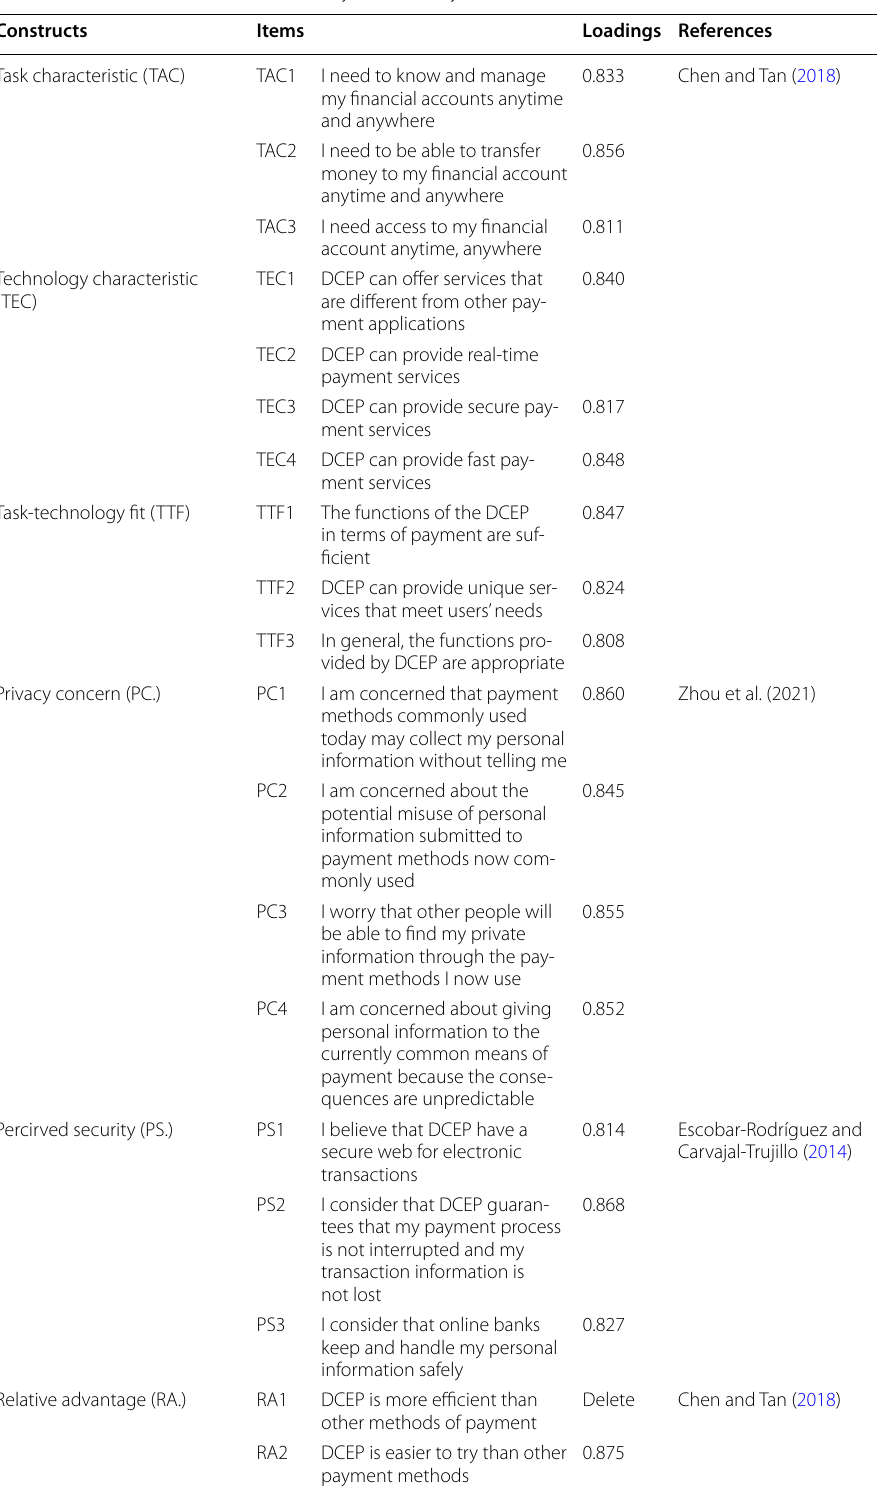
Table 4 The results of the confirmatory factor analysis (CFA) Constructs